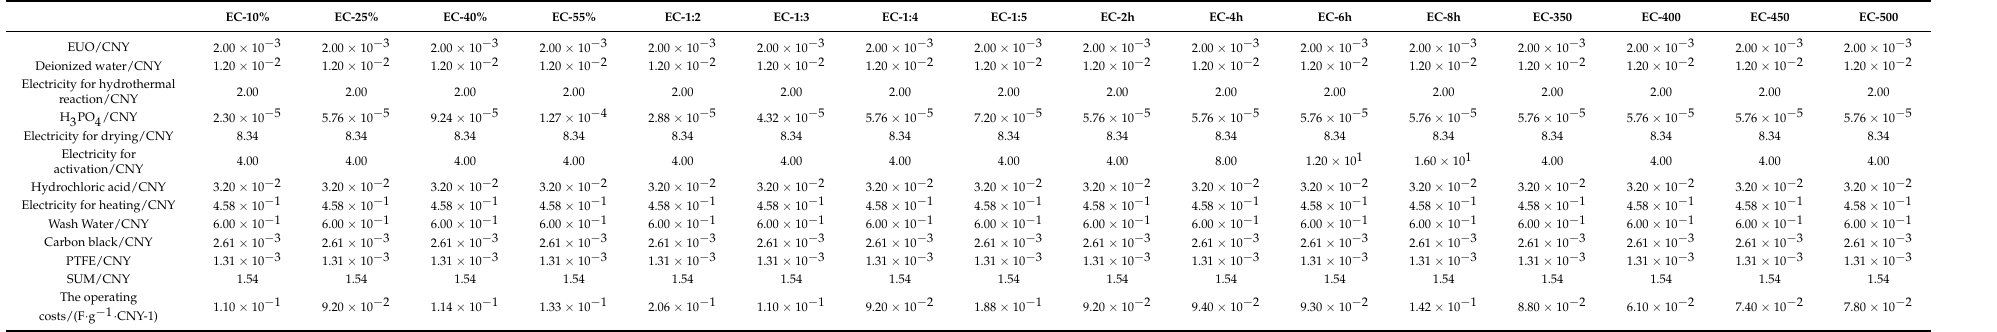
Table 5. The operating costs are based on units of specific